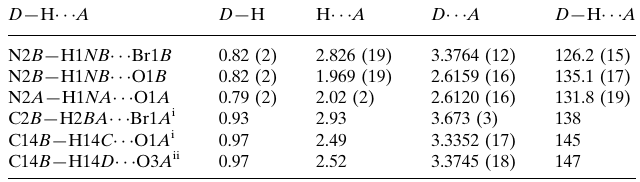
Data collection Bruker SMART APEXII CCD area-detector diffractometer Absorption correction: multi-scan ( SADABS ; Bruker, 2005) T min = 0.238, T max = 0.381